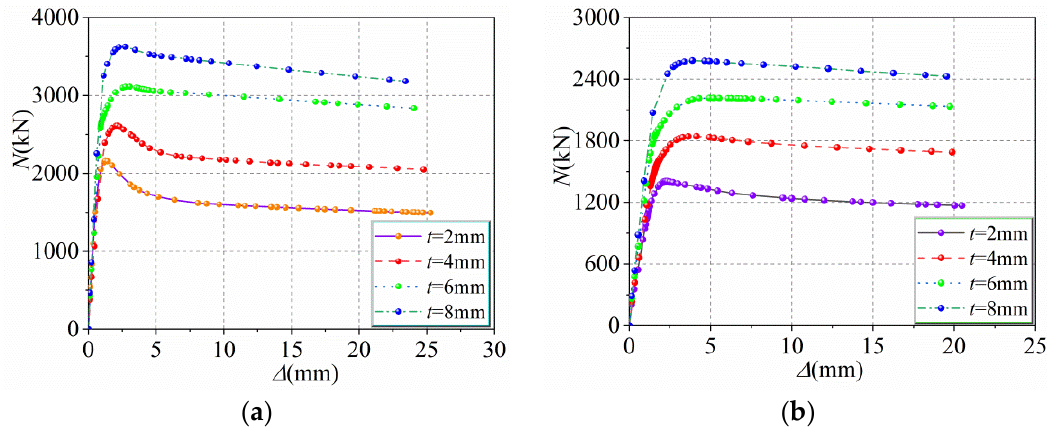
Figure 6. Curves of load – deflection for specimens with various t : ( a ) e = 20 mm; ( b ) e = 50 mm.